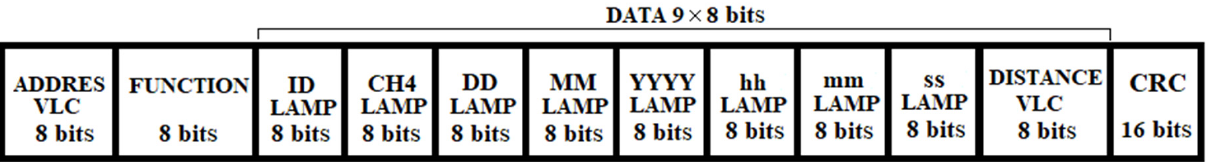
Figure 21. The structure of the MODBUS RTU protocol data frame.